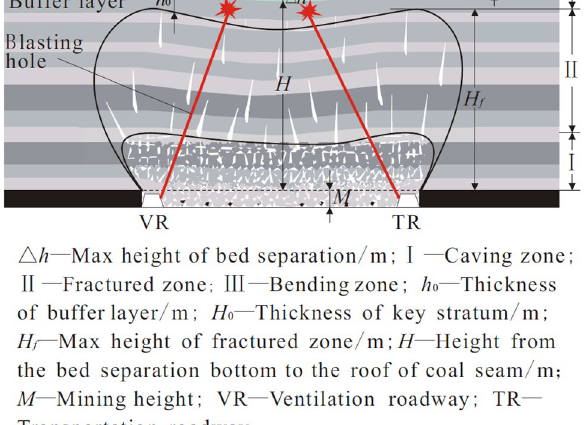
Fig. 1 Diagram of disastrous bed